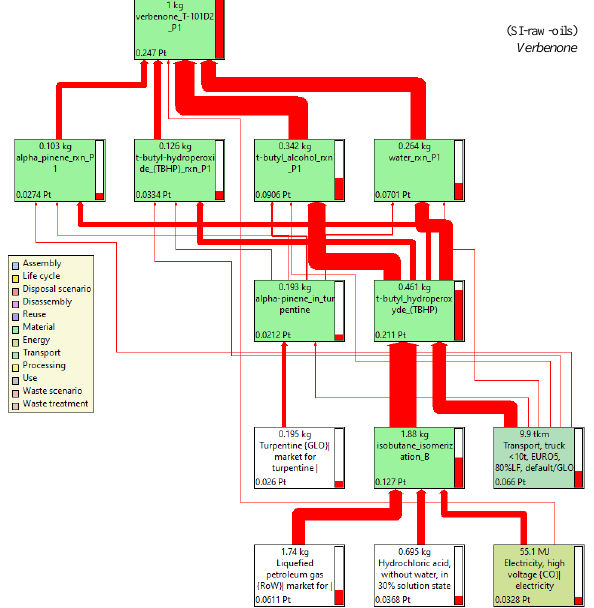
Figure 14. Network diagram by single score of the process for verbenone production in the SI-raw- oils scenario. Assessment method: ReCiPe 2016 Endpoint (H) V1.06/World (2010) H/A. Functional unit: 1 kg of verbenone/batch, Node cut-off: 8%, cumulative indicator as percentage.